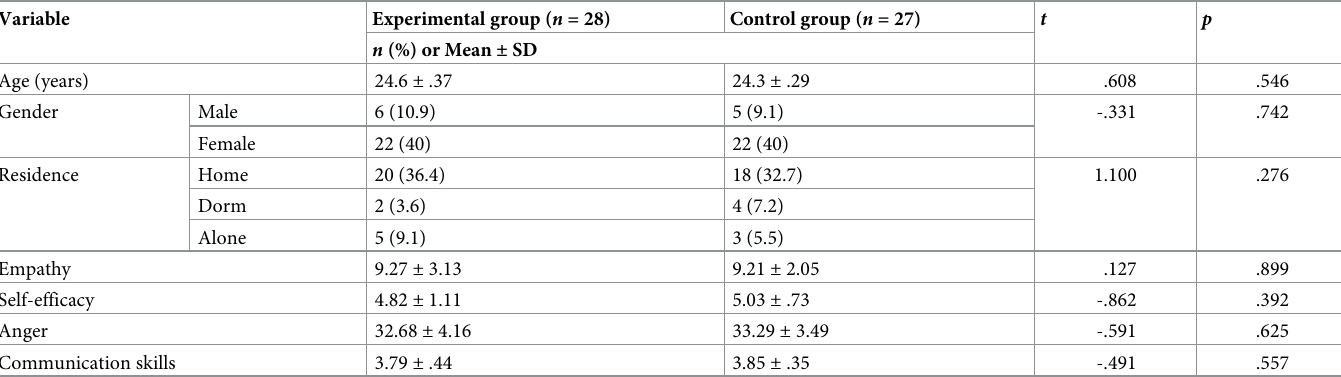
Table 2. Homogeneity of outcome variables.